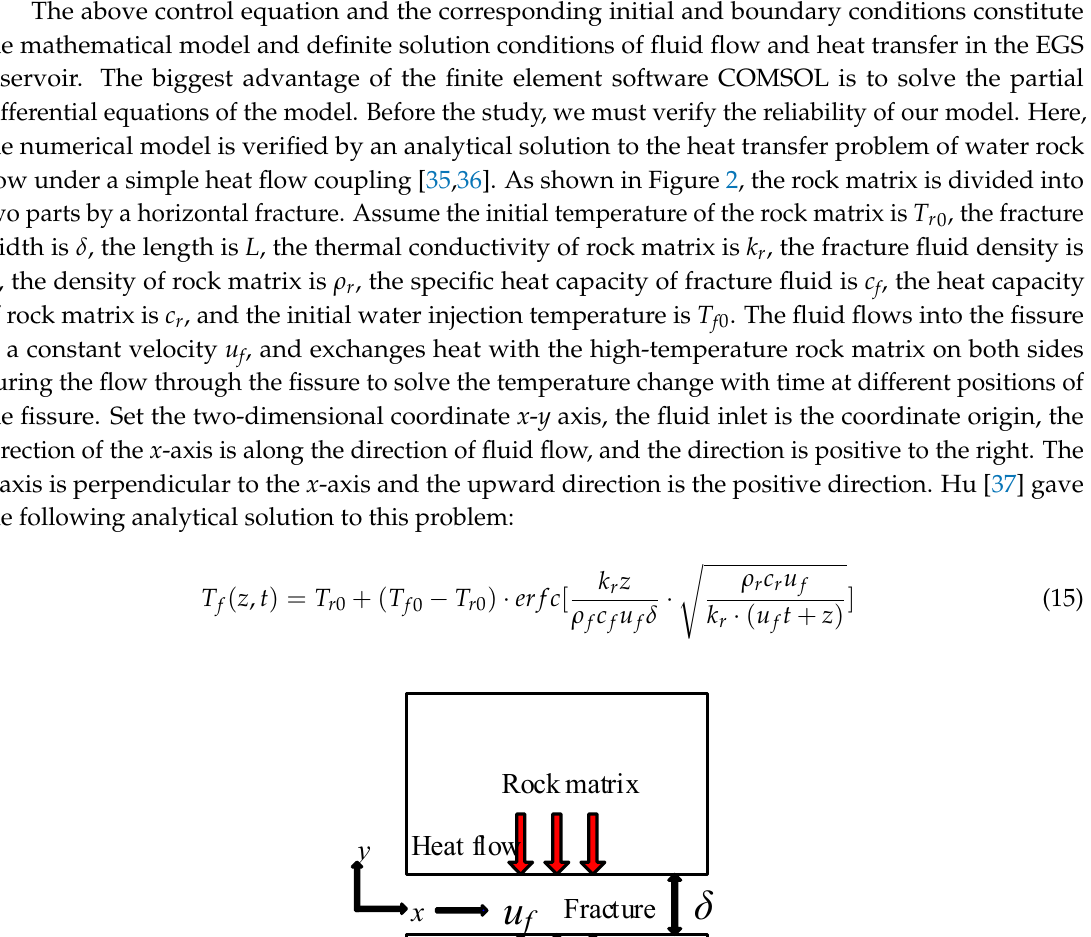
( b ) Figure 3. Comparison of numerical and analytical solutions for two-dimensional single-fracture model. ( a ) Temperature variation with time at different locations in the fracture; ( b ) Temperature variation with position at different times in the fracture. 2.3. Model Establishment of Enhanced Geothermal System Fissured rock masses are a kind of complex engineering medium, which is wide spread in slopes and underground caverns, such as in the fields of energy, transportation, mining and hydraulic engineering [38–40]. The EGS reservoir rock mass with good open fractures has been successfully reformed by hydraulic fracturing, which must be considered in the numerical simulation. At present, the equivalent method is used for the fractured rock mass with dense fracture distribution, which is